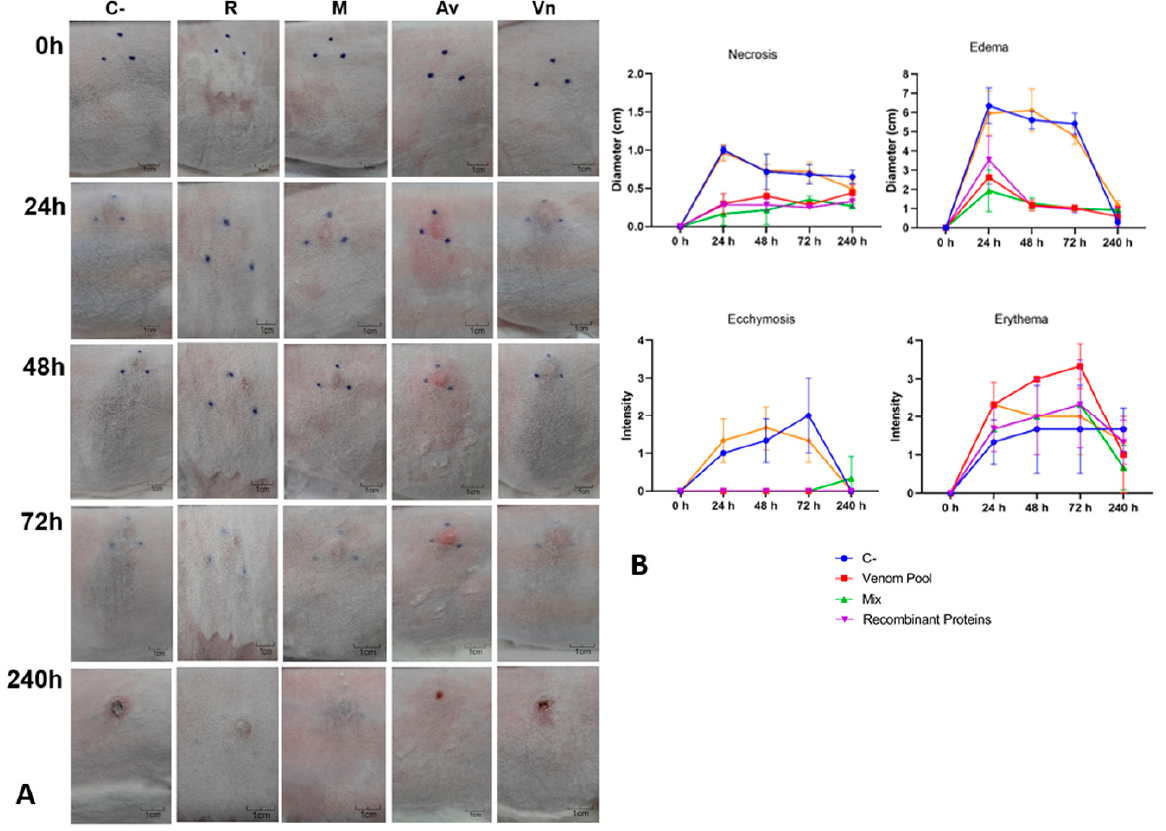
Figure 5. Neutralization of cutaneous loxoscelism triggered by 1 MND of venom tested with pre- incubation. One MND (3.05 µg) of L. intermedia venom previously incubated with each serum was injected (I.D.) in the back skin of rabbits (groups of five animals). ( A ) Macroscopic aspect of injected area after the indicated time courses. C-: C serum. R: REC serum. M: MIX serum. Av: AV serum.